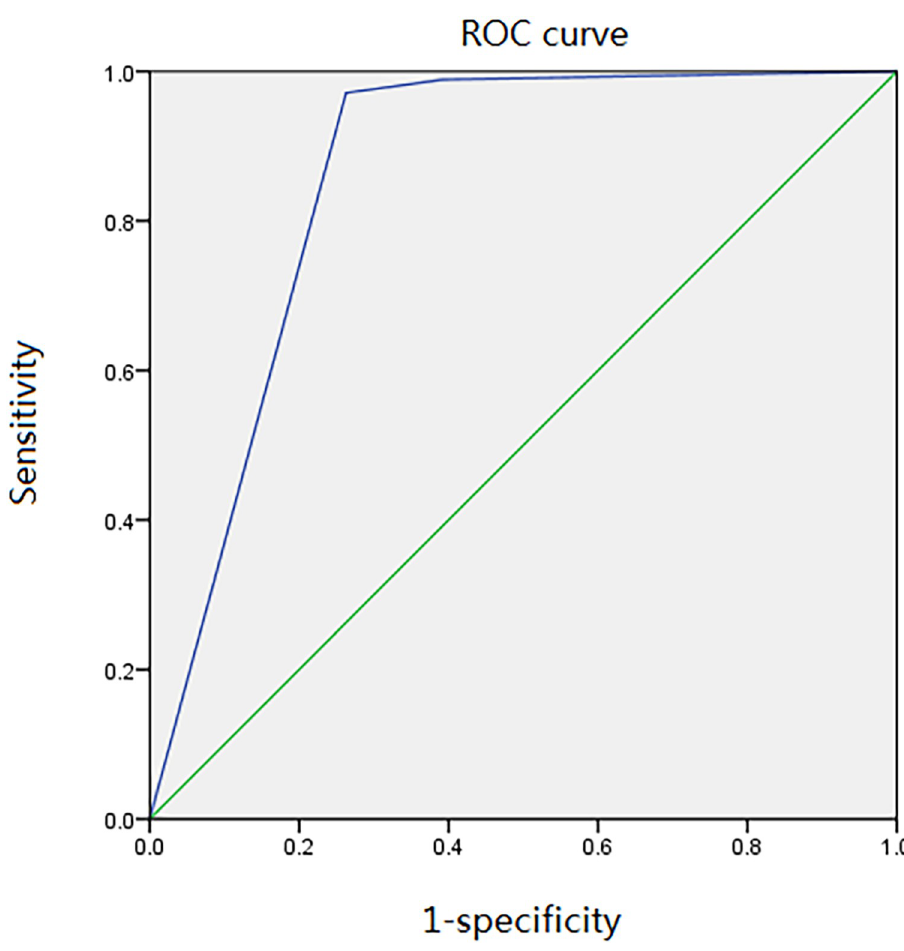
Fig 4. ROC Curve of MRI and arthroscope/open surgery.